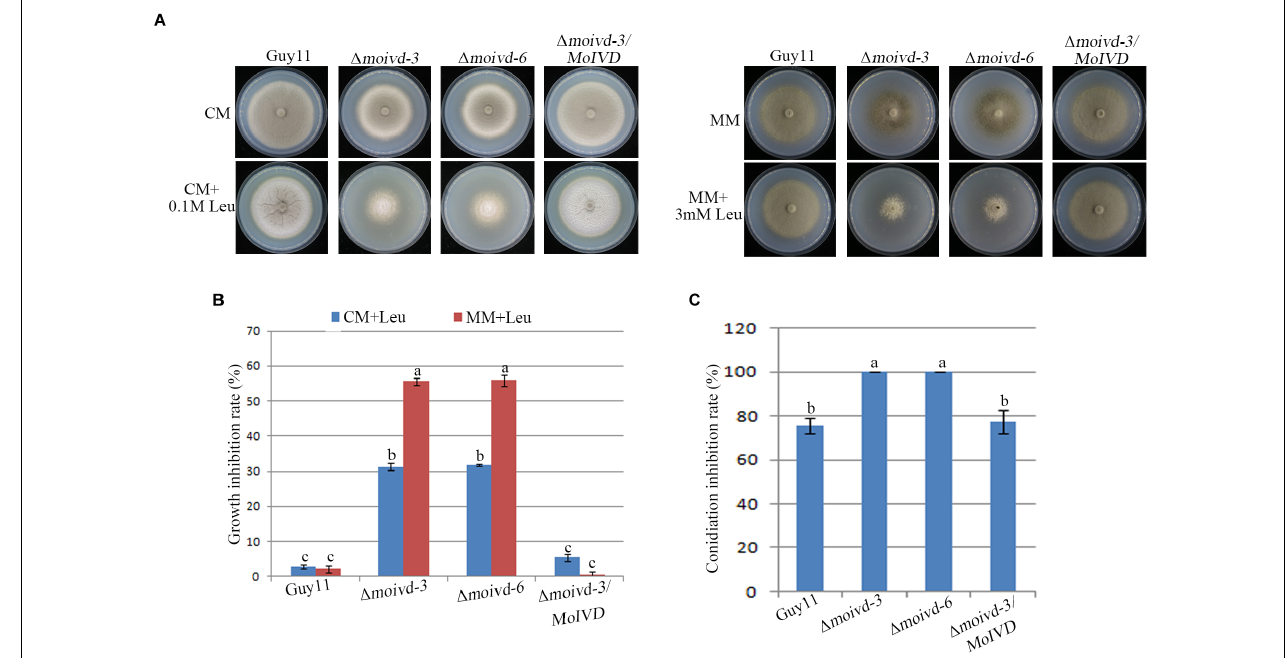
FIGURE 5 | The growth and conidiation phenotype of the (cid:49) moivd mutants under leucine treatment. (A) The growth phenotype of the (cid:49) moivd mutants growing on complete medium (CM) and minimal medium (MM) with adding leucine (Leu). The left panel is the assay performed on CM medium. The right represents MM. The upper panel represents the colony front. The lower panel represents the back of the culture plate. As the mutant growth on MM was very sensitive to high concentrations of leucine, only 3 mM leucine was added in MM. (B) Bar chart showing the growth inhibition rate of the (cid:49) moivd mutants growing on leucine containing medium. (C) Bar chart showing the conidiation inhibition rate of the (cid:49) moivd mutants growing on leucine containing CM medium. All these data were calculated from three independent replicates. The same lowercases ‘a’ or ‘b’ on the sample bar indicate no significant differences between samples. The different lowercases indicate significant differences ( P < 0.05; t